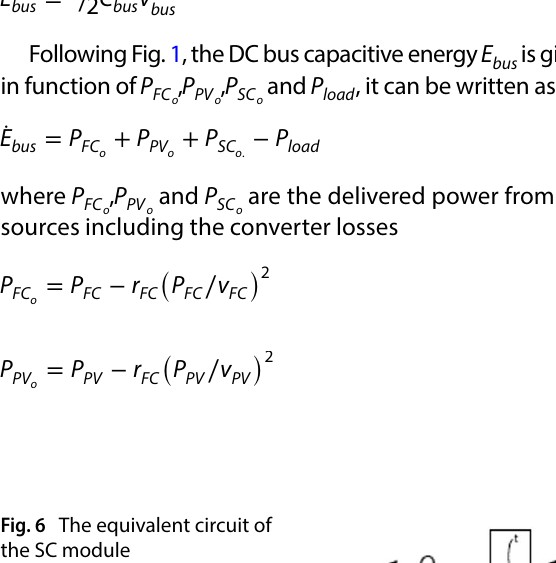
Fig. 6 The equivalent circuit of the SC